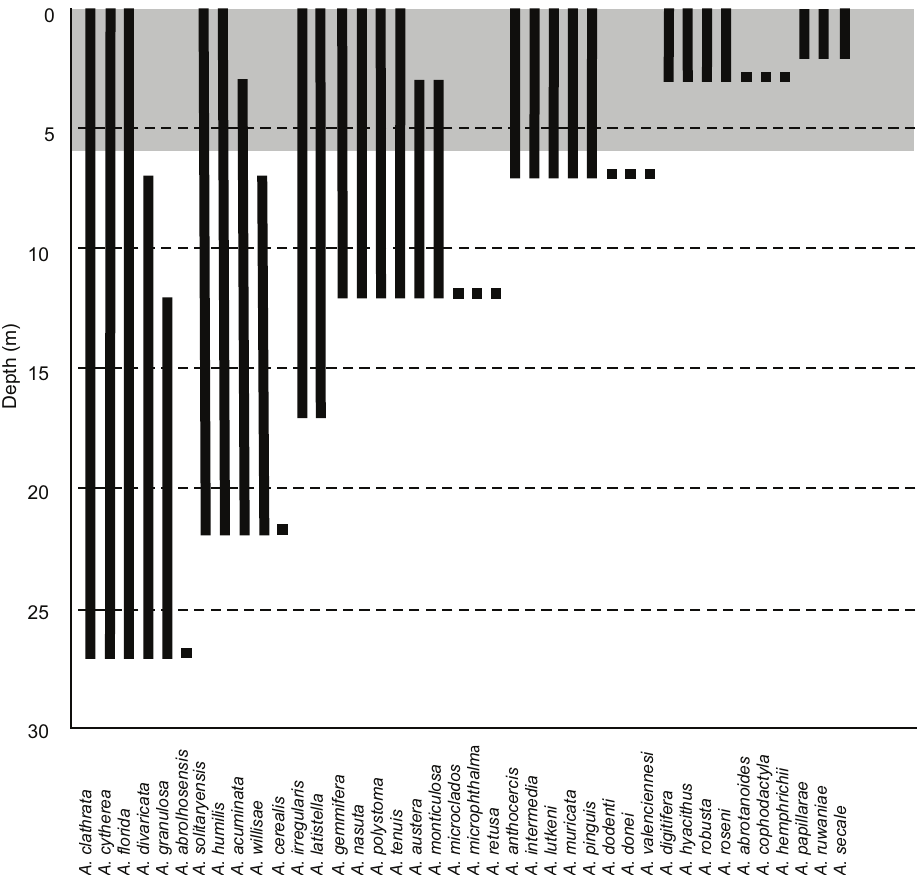
Figure 2. Depth distribution of 40 Acropora species observed at Pulau Weh following the bleaching event. Shaded (grey) panel indicates the depth range where bleaching mortality was high. Of the 29 species occurring in 0–7 m depth, 19 (66%) also occurred below 7